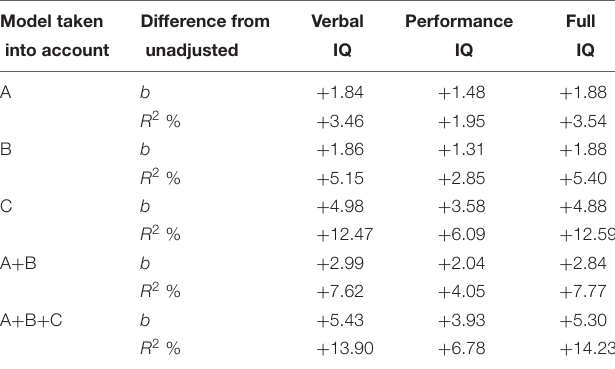
TABLE 3 | Summary of changes in regression coefficient and of the proportion of variance explained by the different models compared with the unadjusted model. Model taken Difference from Verbal Performance Full into